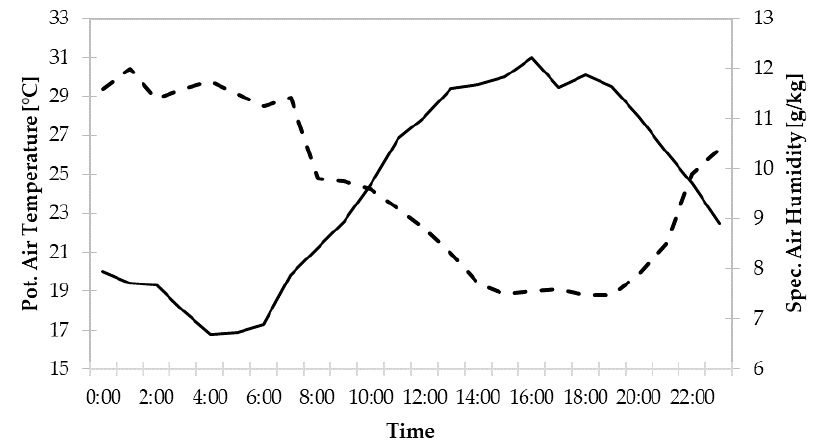
Figure 5. Meteorological boundary conditions for the proof-of-concept simulation. Potential air temperature (solid line) and specific air humidity (dashed line).